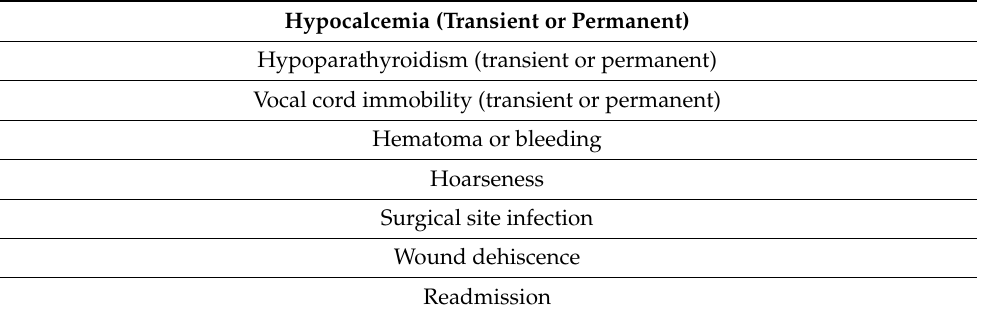
Table 1. Pediatric thyroidectomy complications.